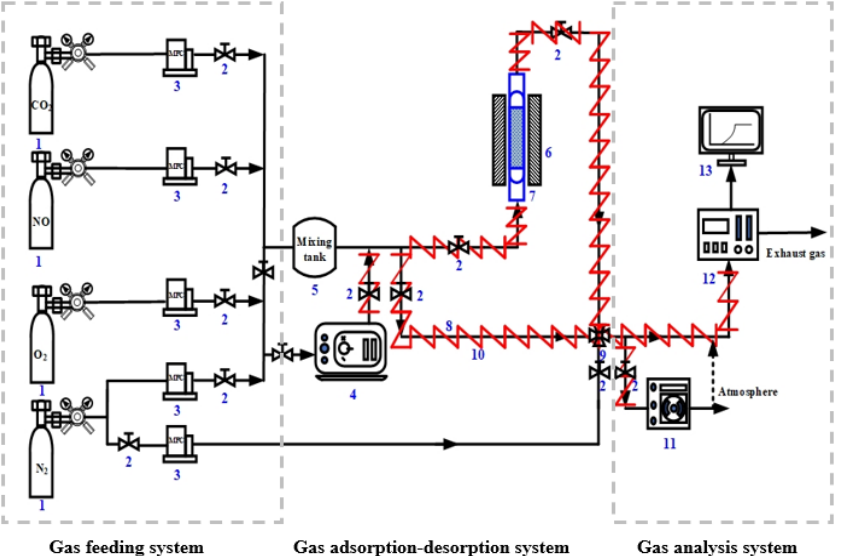
Figure 1. Schematic diagram of NO x adsorption-desorption experimental setup, with the components: 1 — gas cylinder, 2 — ball valve, 3 — mass flow controller, 4 — steam generator, 5 — mixing tank, 6 — furnace, 7 — adsorption column, 8 — bypass line, 9 — four-way valve, 10 — electric heating belts (red), 11 — hygrometer, 12 — flue gas analyzer, and 13 — data collection device.